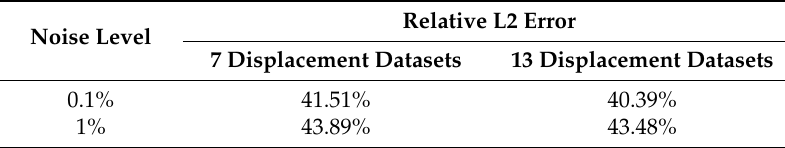
Table 1. Relative L2 error for each case presented in Figures 2 and 3.